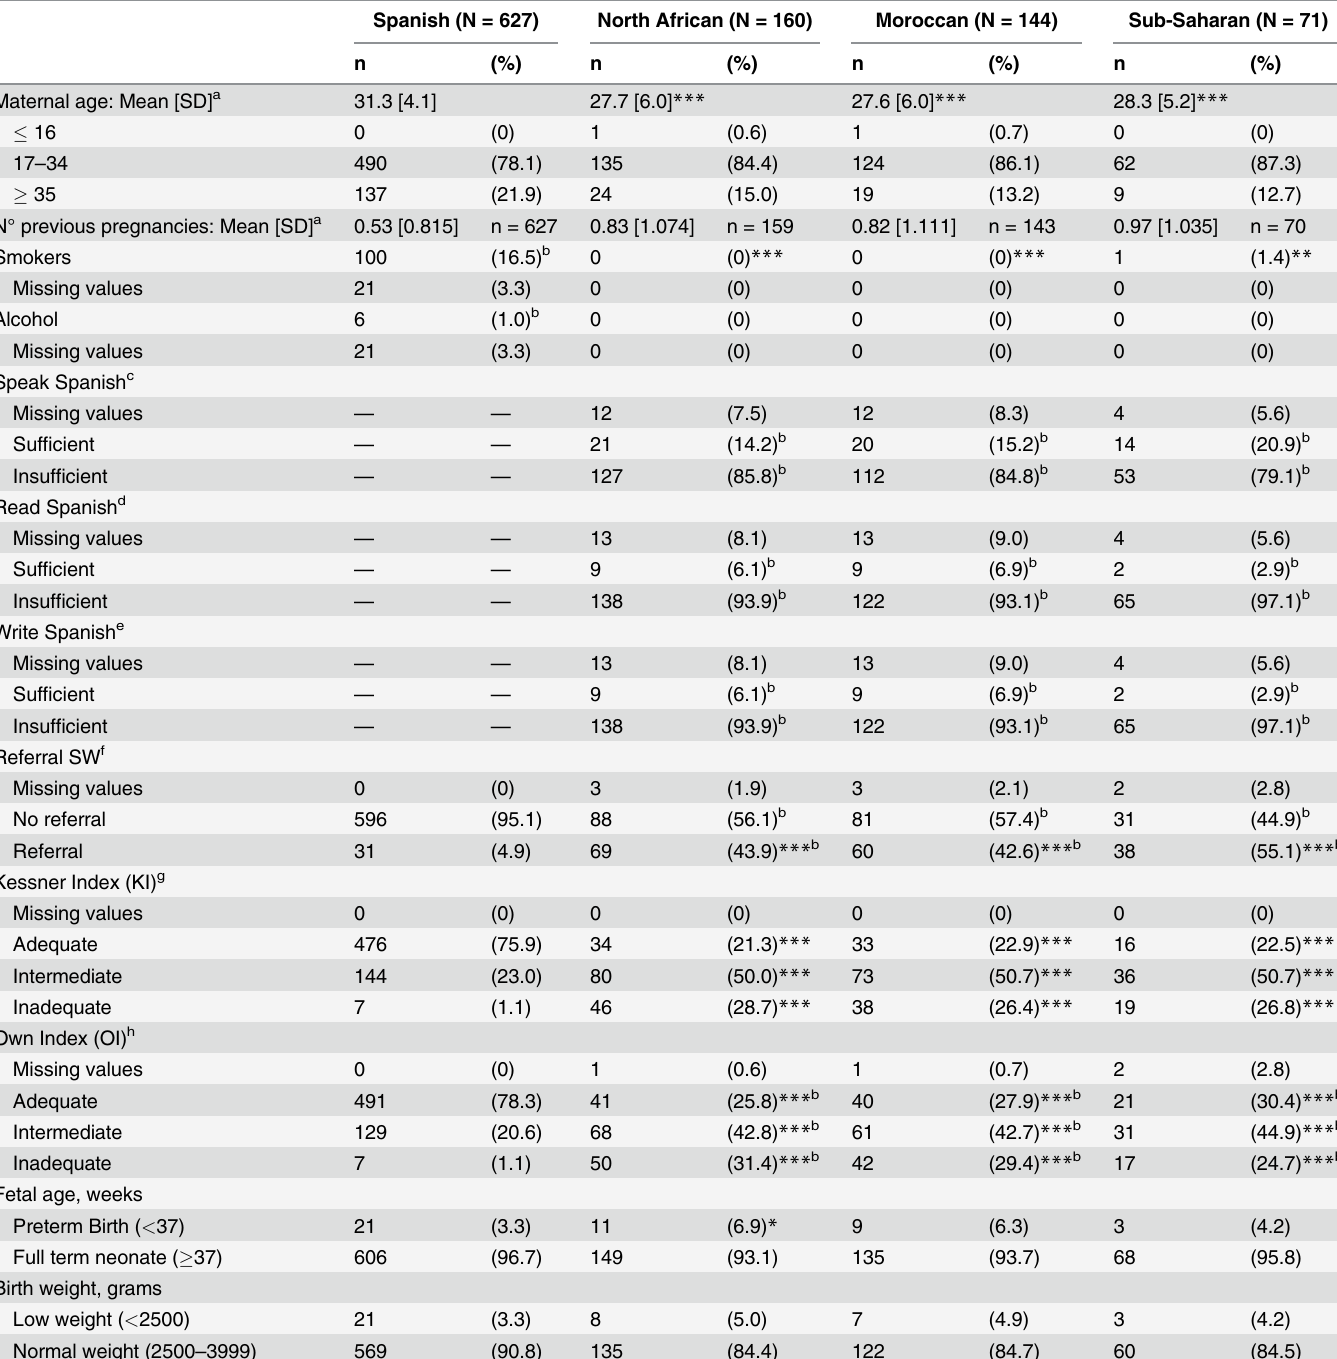
Table 1. Characteristics of the mothers and their newborn, depending on their country of origin. Cantabria (Spain): African immigrants and Spanish women 2007 –